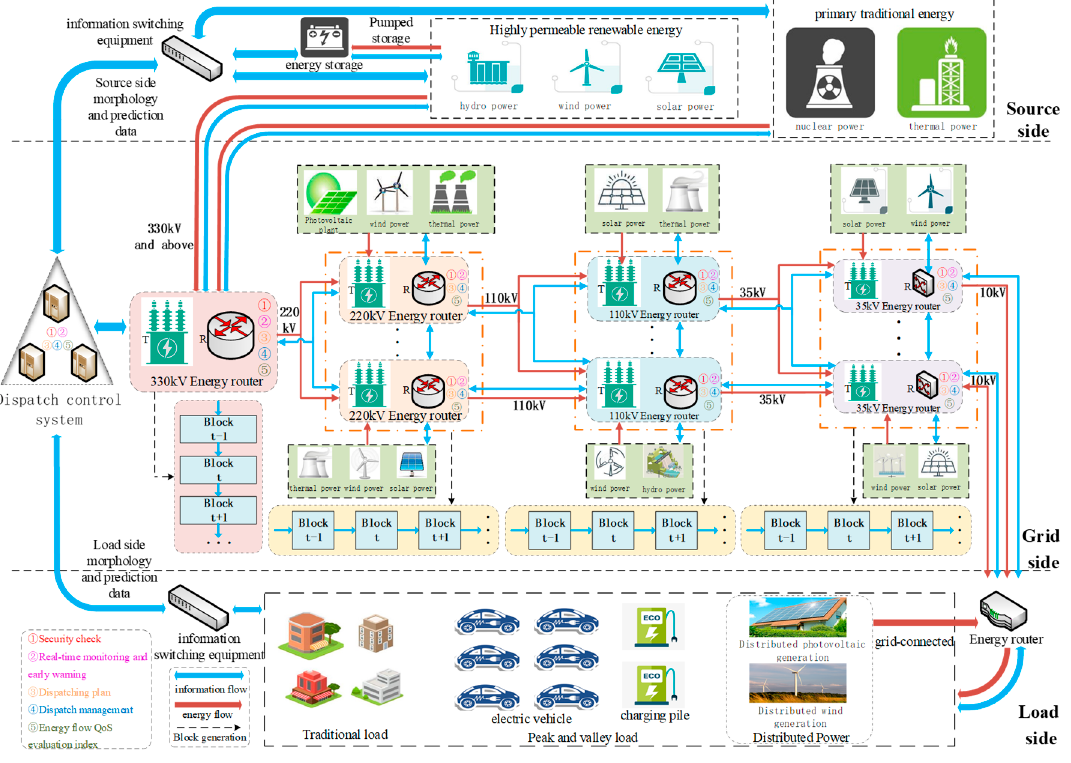
Figure 1. The “source–grid–load” operation model for renewable energy access .